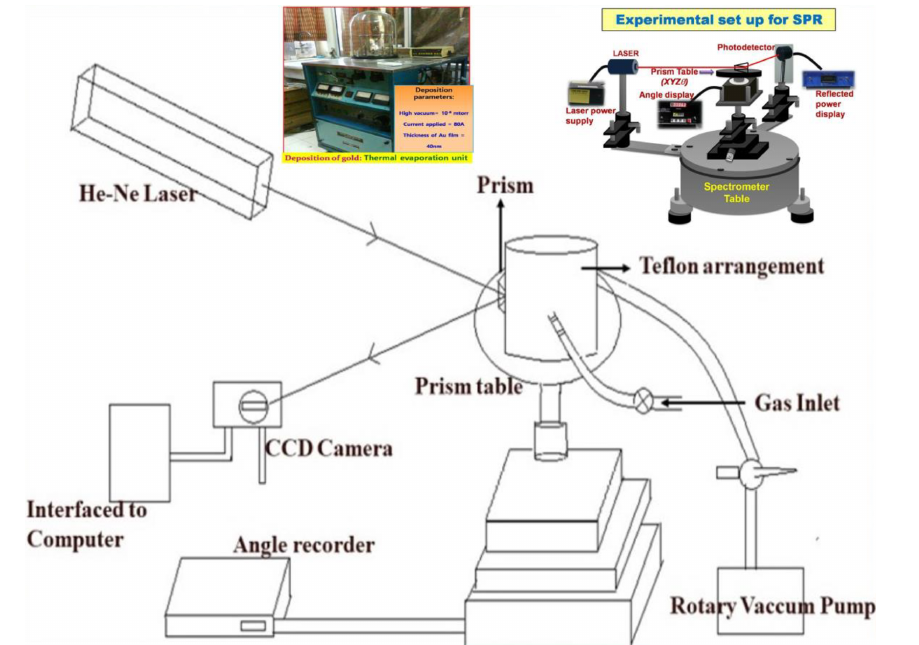
Figure 1. R.F. magnetron sputtering to grow the ZnO / Au thin films.